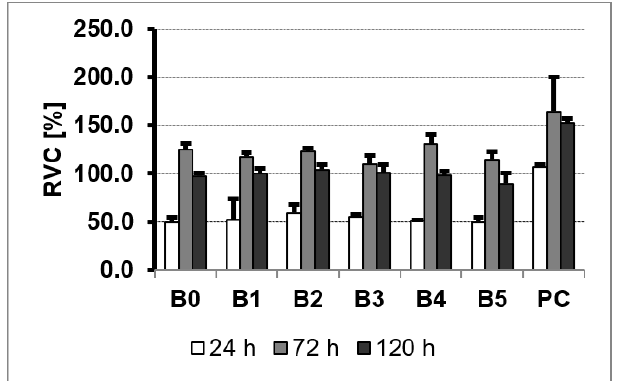
Figure 11. The results of the MTS assays performed at 24, 72, and 120 h on the viability of the HPdLF: ultrafine-grained Ti23Zr25Nb alloy (B0), ultrafine-grained Ti23Zr25Nb alloy electrochemically modified (B1), and Ti23Zr25Nb—9 wt.% 45S5 Bioglass (B2), Ti23Zr25Nb—9 wt.% 45S5 Bioglass—1 wt.% Ag (B3), Ti23Zr25Nb—9 wt.% 45S5 Bioglass—1 wt.% Cu (B4), Ti23Zr25Nb—9 wt.% 45S5